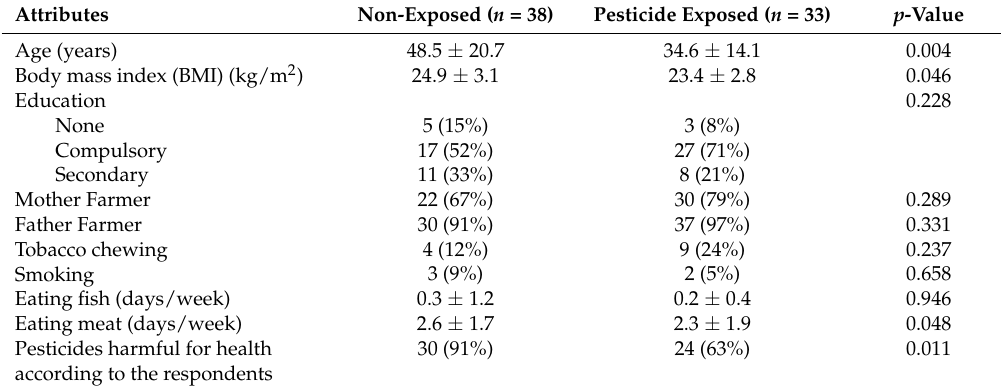
Table 1. Comparison of personal lifestyle and educational background for non-exposed and pesticide exposed male farm workers in Jarabacoa, mean +/ − SD and percent.